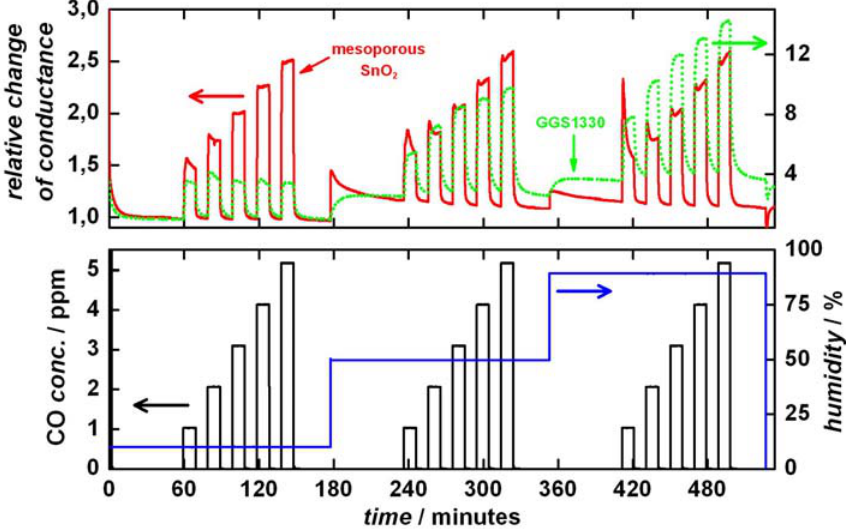
Figure 4. Gas sensor measurement showing the CO concentration (bottom, black line), the humidity (bottom, blue line), and the relative change of conductance of the sensor prepared with mesoporous (top, red line) and of the commercial SnO -based sensor (GGS1330, top, dotted green SnO 2 2